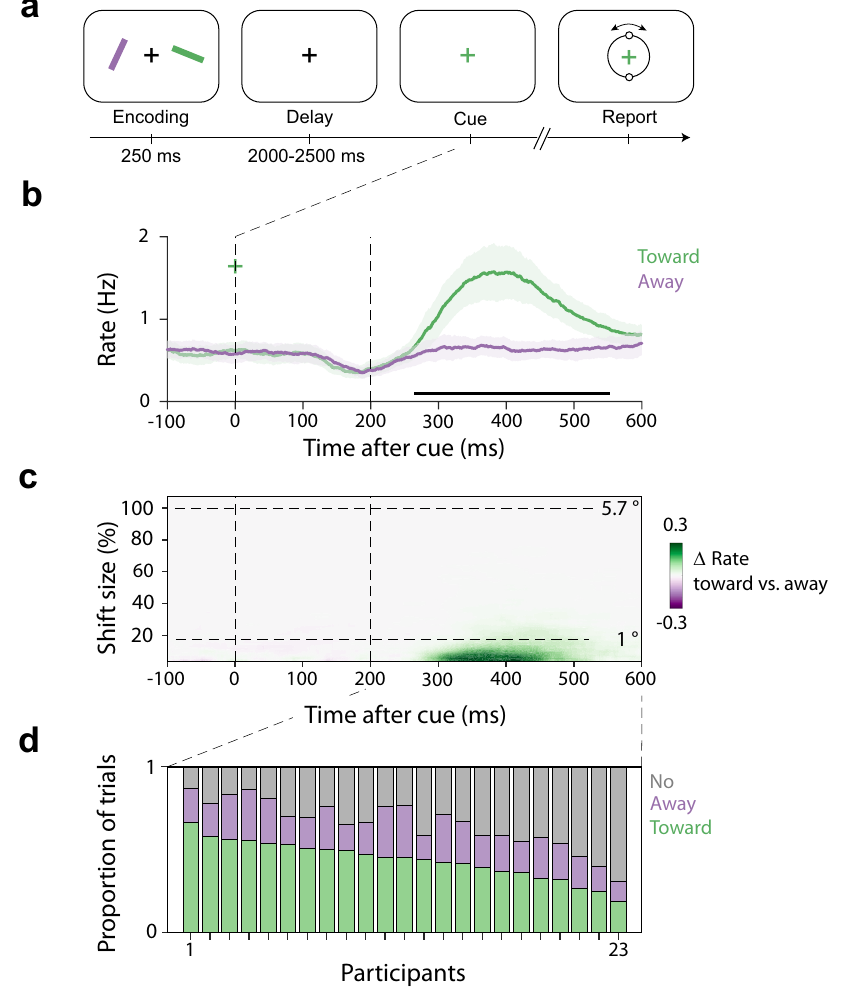
Fig. 1 Directional biases in microsaccades during internal spatial attention following a non-spatial colour cue. a Task schematic. Participants memorised two orientated bars with different colours to reproduce the orientation of one bar stored in working memory after a short delay. Following the delay, a colour change of the central fi xation cross served as the attentional cue that prompted participants to select and report the orientation of the colour- matching item from memory. After response initiation, a central response dial appeared on the screen and participants performed a reproduction report. b Time courses of gaze shift rates (number of microsaccades per second) for shifts toward and away from the memorised location of the cued memory item. Black horizontal line indicates the signi fi cant temporal cluster (cluster-based permutation test). Time courses show mean values, with shading indicating 95% CI (calculated across 23 participants). c Difference in gaze-shift rates (toward minus away; see Supplementary Fig. 2 for towards and away separately) as a function of gaze-shift magnitude. For reference, dashed horizontal lines indicate 1° visual angle, as well as the original location of the memory item (100% in our analysis, corresponding to 5.7°). d The relative proportion of toward, away, and no-microsaccade trials in the 200 – 600 selection window, as a function of participant. For visualization purposes, we sorted participants by their proportion of toward-microsaccade